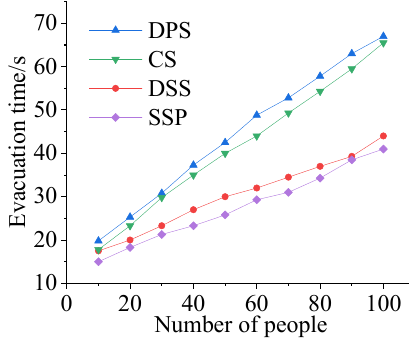
Figure 7. Effect of crowd density.